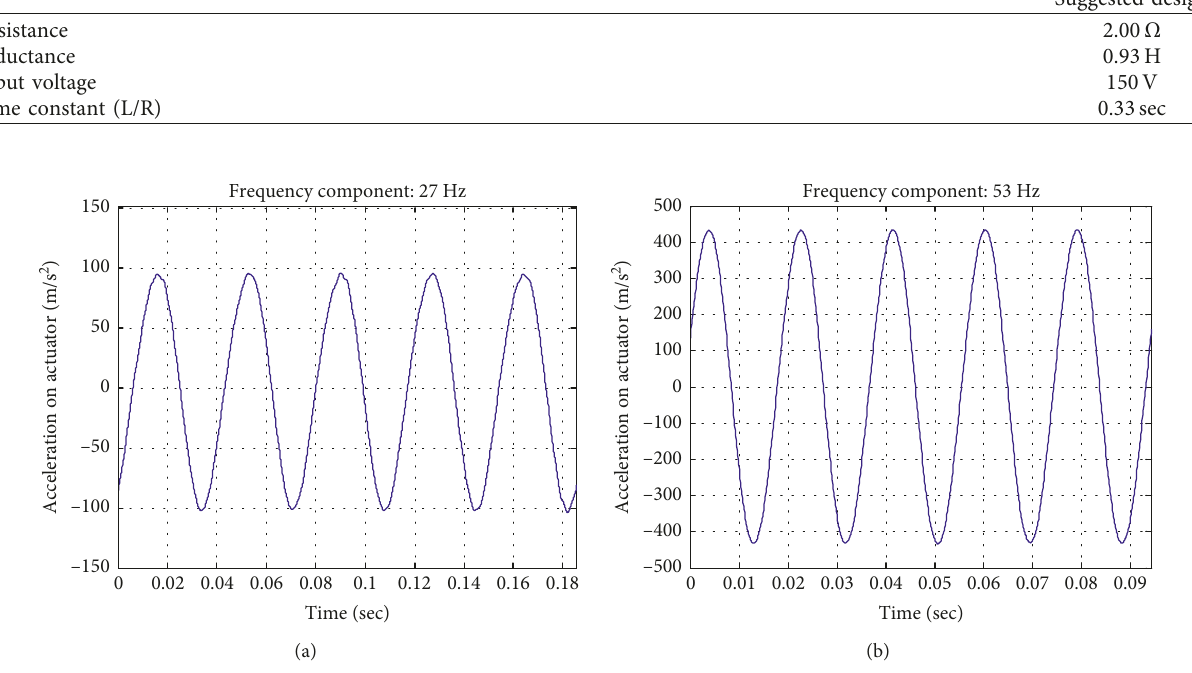
Figure 11: Acceleration of modified actuator for command input voltage of pure sine. (a) 27Hz. (b)